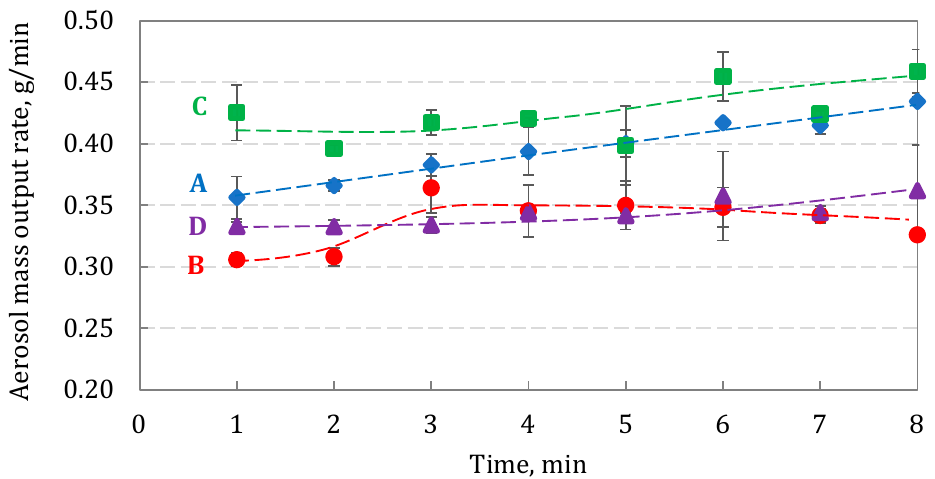
Figure 9. Aerosol mass output rate of BUD suspensions A, B, C, and D. Error bars show the standard deviation ( n = 3). Lines are drawn to guide the eye. Table 5. The average mass output (aerosol emission) rate of BUD suspensions in the VMN. SD denotes the standard deviation ( n = 3).